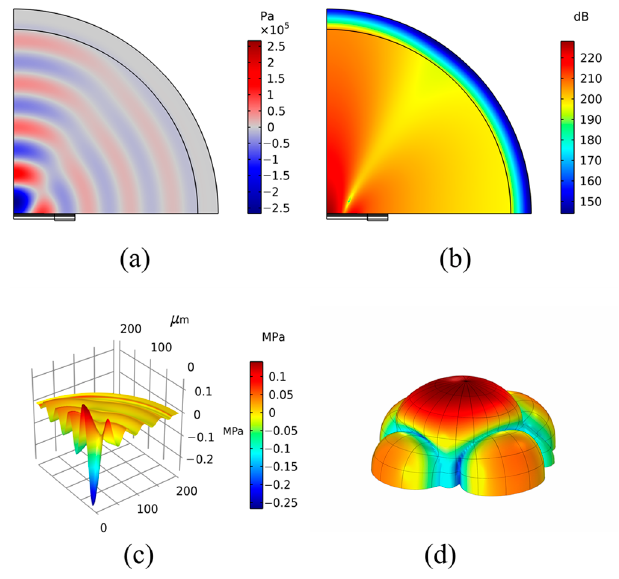
Figure 5. Two-dimensional axisymmetric diagram of the sound field: ( a ) 2D sound pressure map (Pa); ( b ) 2D map of the SPL (dB); ( c ) 2D height map of sound pressure; ( d ) sound wave radiation profile.